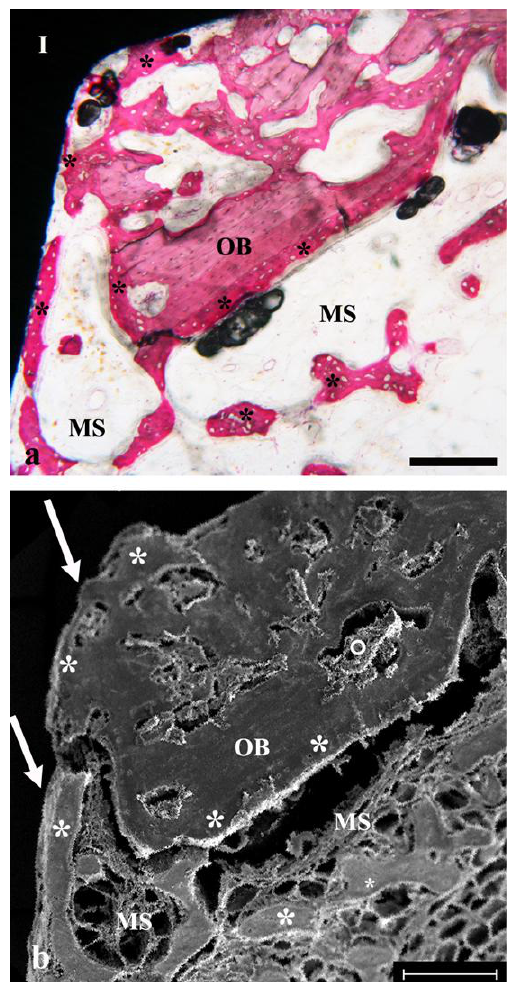
FIGURE 1. LM-SEM correlative analysis of the osteointegration process 4 weeks after implant insertion. (a) Section of a bone-implant sample observed by LM. Newly formed bone trabeculae (*) can be seen at the bone-implant interface, adhering both to the pre-existing bone surface and to the implant surface. I = implant; MS = medullar spaces; OB = pre-existing bone. (LM, bar = 200 μm). (b) Same section area shown in Fig. 1a after deacrylation of the section, implant removal, and bone processing for SEM. Note the bone trabeculae (*) with osteocytes in their lacunae and the medullar spaces (MS) with blood vessels (°). Implant removal allowed us to disclose the three-dimensional aspect of bone tissue at the bone-implant interface (arrows). (SEM, bar = 200